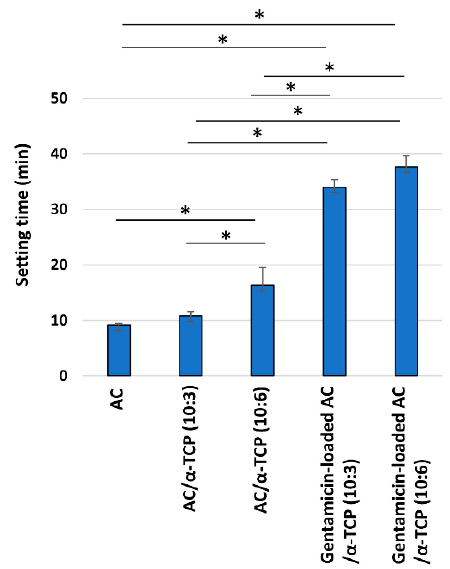
Figure 2. Setting time of gentamicin-loaded AC/ α -TCP composites. * p < 0.05, Tukey’s